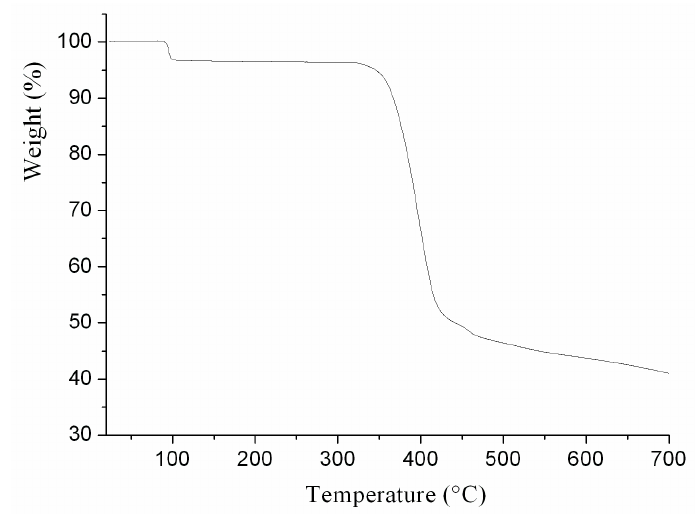
Figure 5. Thermal analysis curve of the complex 1